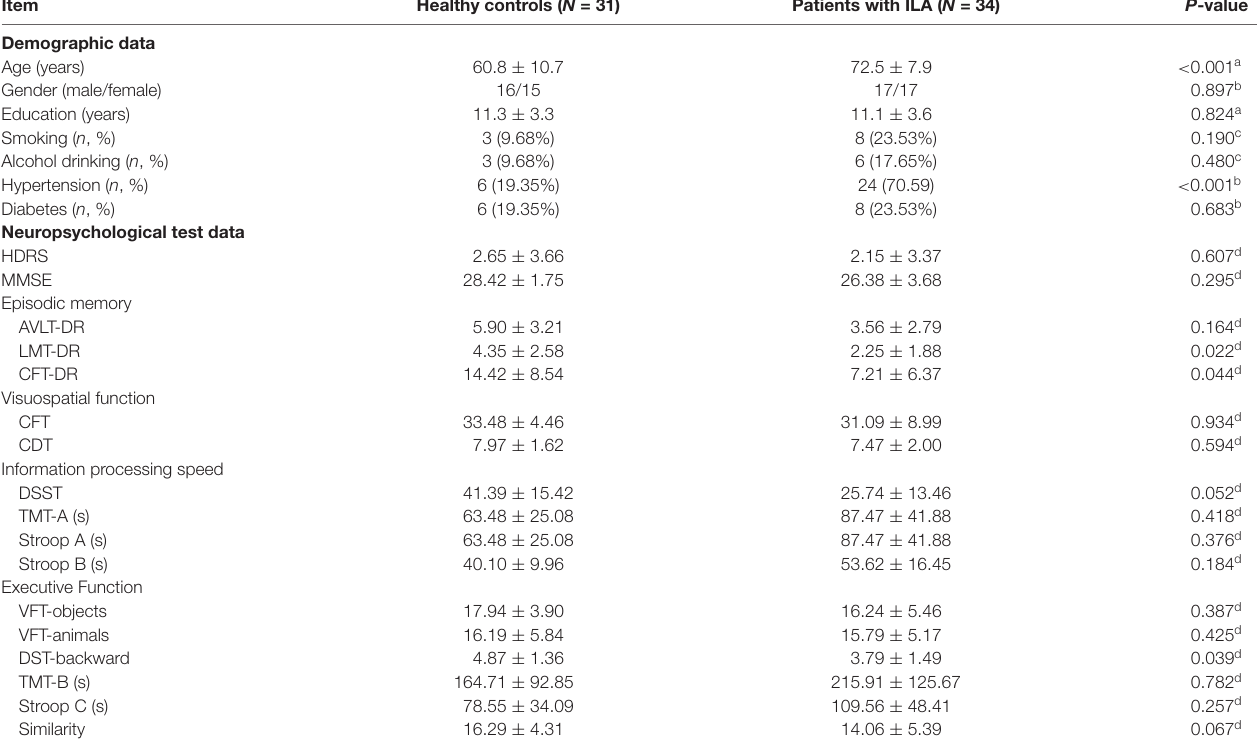
TABLE 1 | Demographic and neuropsychological data for all